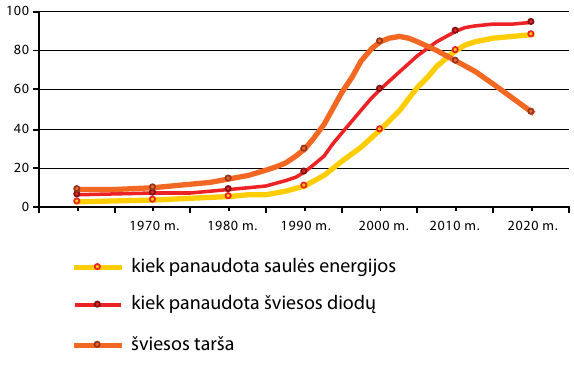
Fig. 24. evolution of lighting fixtures according to